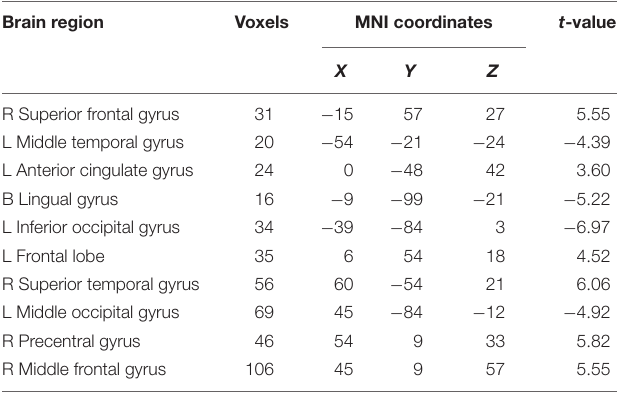
TABLE 2 | Brain regions where the ReHo map differed between the feedback group (FG) and control group (CG). Brain